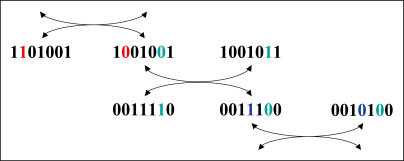
For modeling purposes, metabolites can be denoted as binary strings of biochemical groups; enzymes catalyze the transfer of the groups